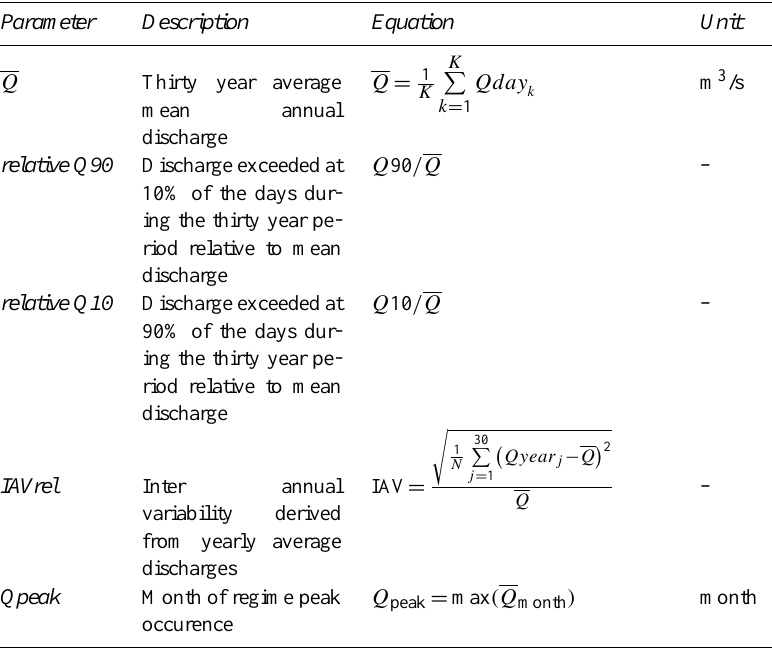
Table 2. Descriptive statistics. Where Qday is a daily discharge value, k corresponds to the day number, K is the total number of days in the 30-year period, Q 90 is the discharge exceeded at 10% of the days during the 30-year period, Q 10 is the discharge exceeded at 90% of the days during the 30-year period, j corresponds to the year number, N is the total number of years (30), Qyear j is the mean annual discharge for the years 1961 to 1990, Q is the 30 year average mean discharge and Q month are the 30-year average mean monthly